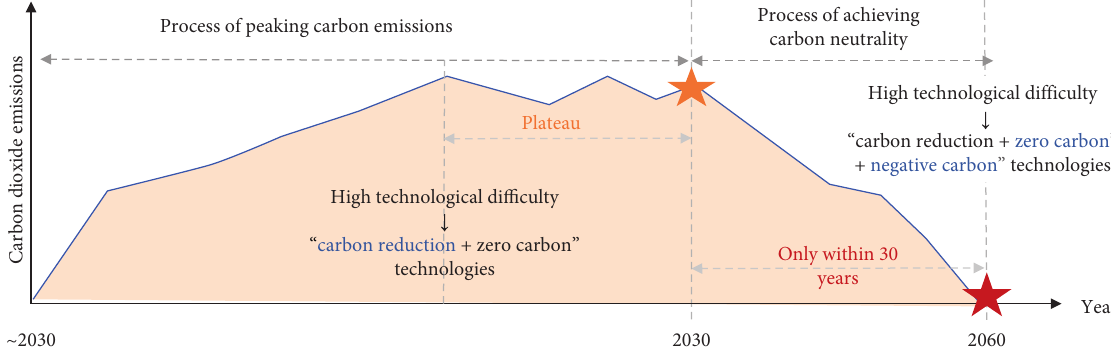
Figure 2: The process of achieving the 30 · 60 target in China.